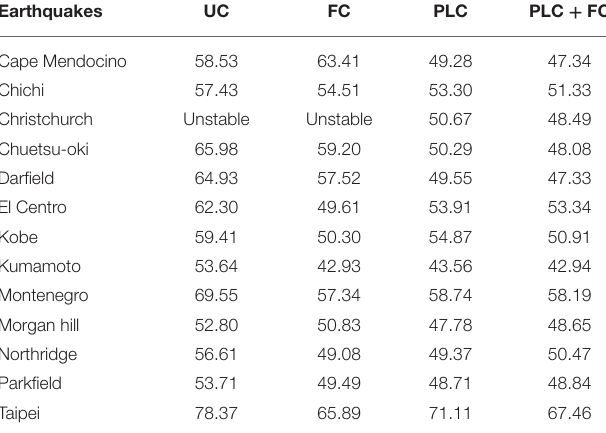
TABLE 2 | RMSE of the substructure acceleration response with various compensation schemes. Earthquakes